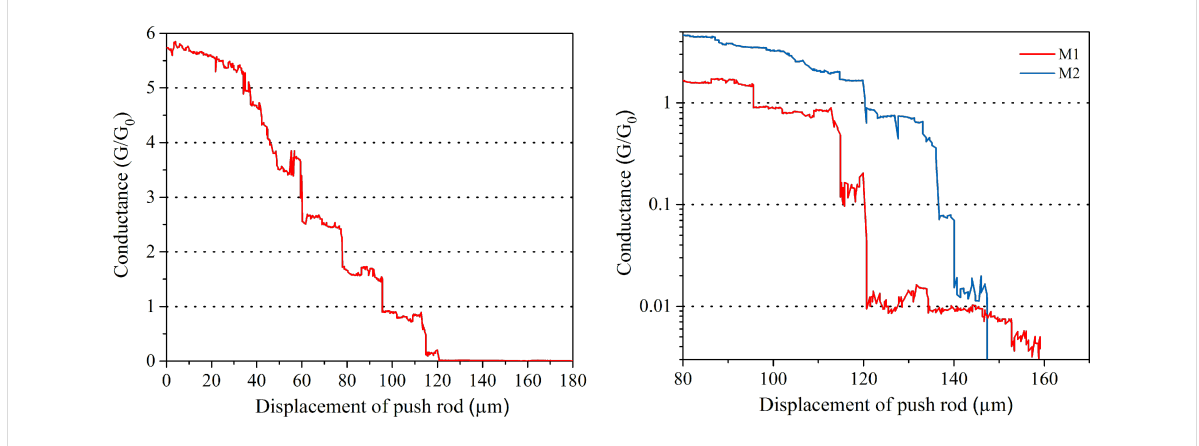
Figure 3: Typical curves of conductance versus mechanical displacement in presence of [1,1’-biphenyl]-4,4’-dithiol ( M1 , red) and 4’-mercapto-[1,1’- biphenyl]-4-carbonitrile molecules ( M2 , blue) during opening the break junction. Left: Conductance in presence of M1 (linear scale), right: comparison of conductance in presence of M1 and M2 molecules.